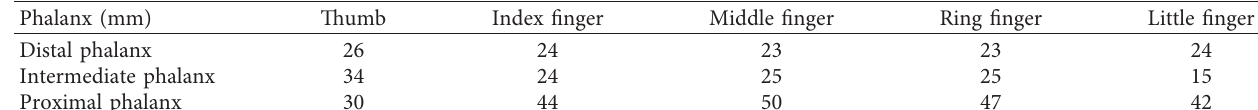
Table 4: Length of each phalanx.